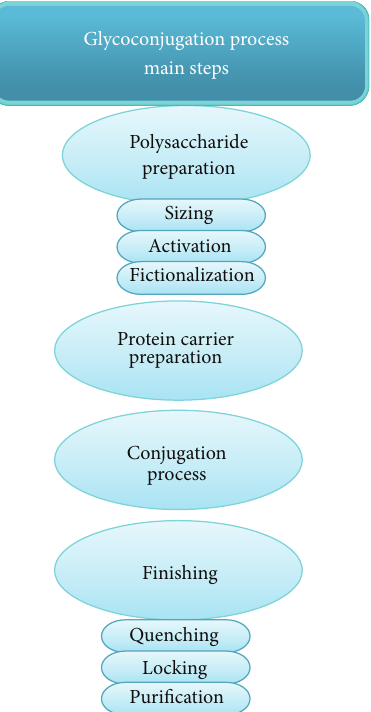
Figure 3: Main steps in the glycoconjugate process.